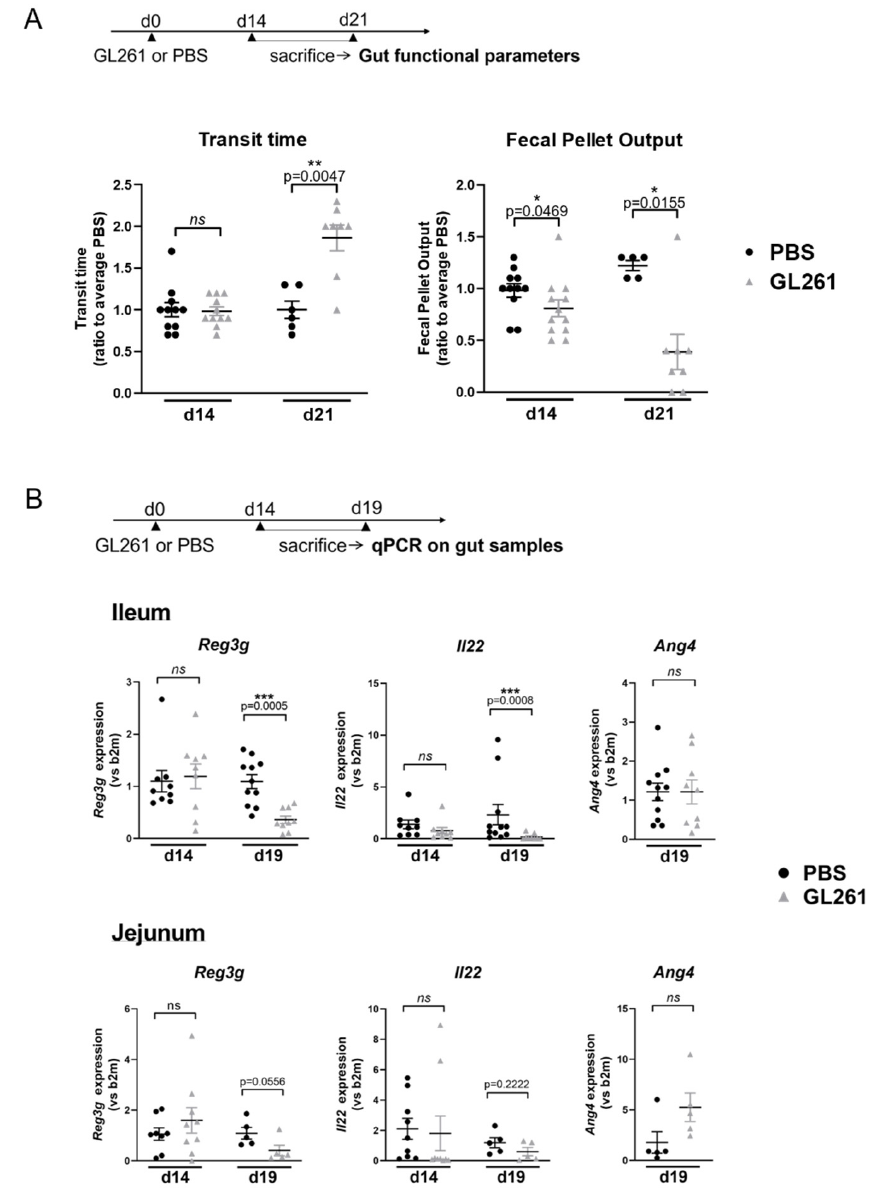
Figure 1. Changes in gastrointestinal motricity and expression level of genes related to small intestinal immunity in mice with late-stage glioma ( A ) Total transit time and fecal pellet output in mice injected with GL261 or PBS, 14 days (d14) and 21 days (d21) after the surgery. Transit time repre- sents the latency before rectal expulsion of orally administered carmine red. Fecal pellet output is the number of stools expulsed in 2 h. Parameters are expressed as percentages of the average value of PBS-treated mice. All values represent means ± SEM (PBS: n = 5–6; GL261: n = 5–8 for d21 and PBS: n = 11; GL261: n = 11–12 for d14). Statistical analyses were performed with the Mann–Whitney U -test, * 0.01 ≤ p < 0.05, ** 0.001 ≤ p < 0.01( B ) Expression level of genes involved in epithelial antimi- crobial defense ( Reg3 γ , Il22 , Ang4) in the ileum and jejunum of mice 14 days (d14) and 19 days (d19) after the surgery. Expression levels are expressed in reference to the b2m housekeeping gene and have been normalized to the average gene expression in PBS-injected mice. All values represent means ± SEM (PBS: n = 11; GL261: n = 9 for the ileum and PBS: n = 4–5; GL261: n = 5 for jejunum for d19 and PBS: n = 8–9; GL261: n = 9 for d14). Statistical analyses were performed with the Mann– Whitney U -test, *** 0.0001 ≤ p < 0.001, ns: non-significant.